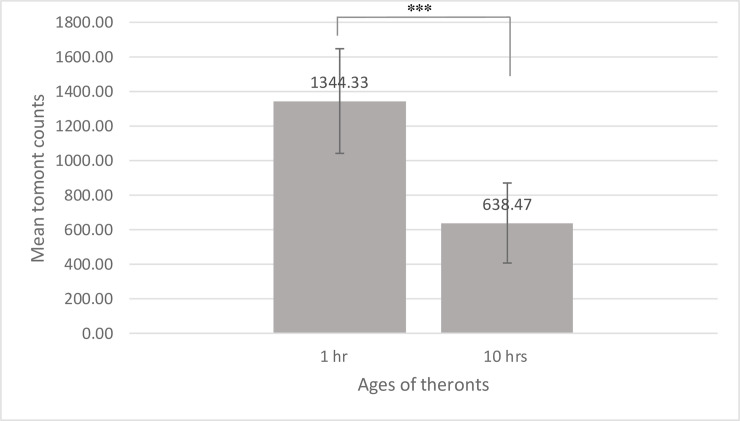
Infectivity of theronts collected from two different time points.Theronts collected from 1 hr and 10 hrs after they emerged from tomonts were used to infect 15 L. calcarifer for each time point. Successful infections that resulted in mature trophonts leaving host fish were measured by the numbers of tomonts collected from each infected fish. Mean tomont counts and standard deviations are provided for both time points (t-test, ***p < 0.001).